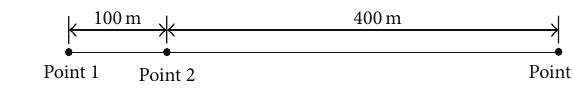
Figure 3: Configuration of the three points.